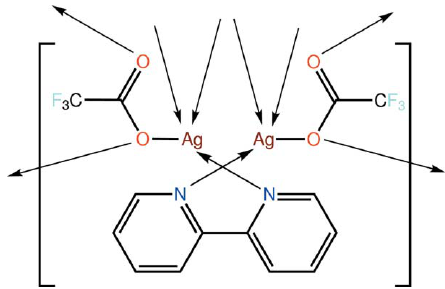
Data collection: CrystalClear (Molecular Structure Corporation